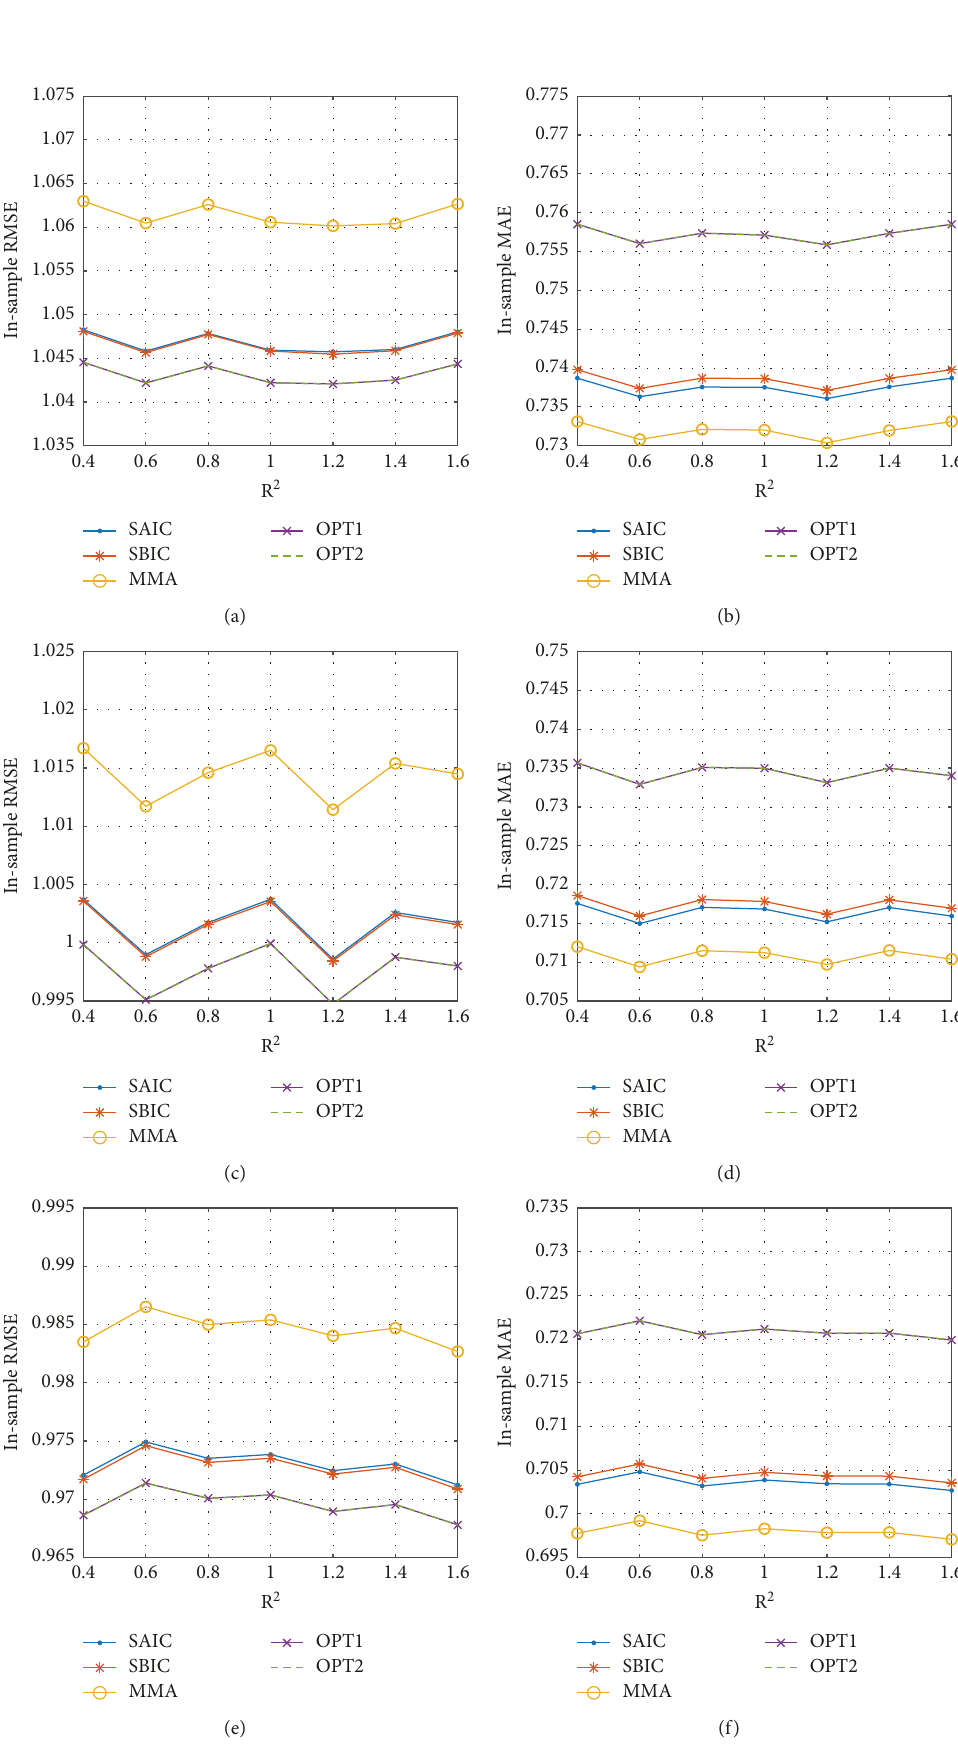
Figure 2: In-sample fitting results with different R 2 for simulation 2. (a) n � 1000. (b) n � 1000. (c) n � 2000. (d) n � 2000. (e) n � 5000. (f) n �